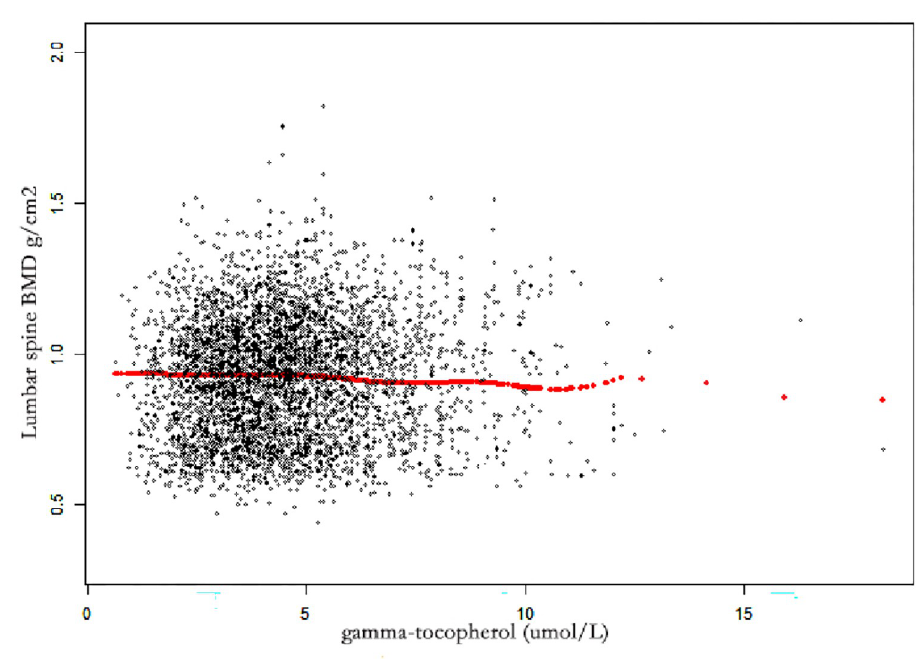
Fig 3. The associations between γ -tocopherol and lumbar spine BMD. Each black point represents a sample. Age, gender, race/ethnicity, PIR, BMI, serum calcium, and serum phosphorus were adjusted. Abbreviations: PIR, poverty income ratio. BMI, body mass index. BMD, bone mineral